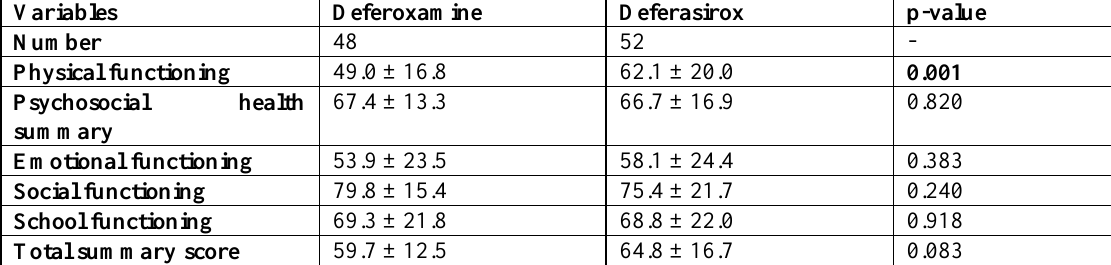
Table (6) Assessing HRQoL in pediatrics using PedsQL